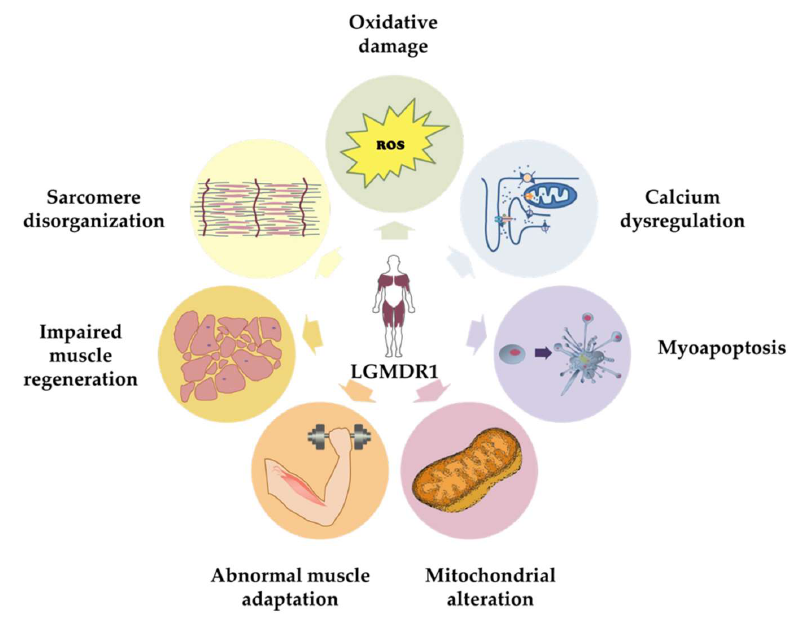
Figure 2. Illustration of the pathological features of CAPN3 deficiency in the skeletal muscle.